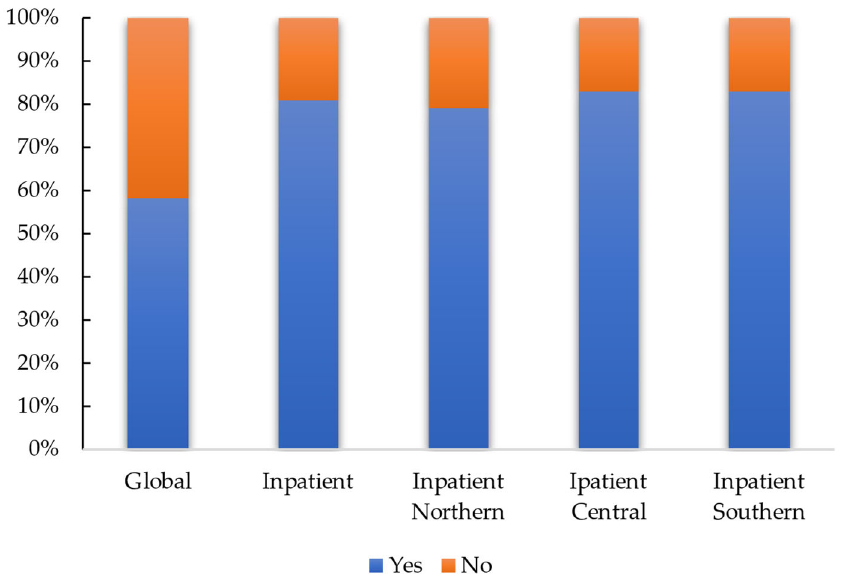
Figure 2. The graph shows the percentage of responses regarding the presence of the multidisciplinary team at national level (global) and focusing the analysis on physiotherapists who work in a hospital setting (inpatient), among these stratifying the data geographically. Distribution: as regards the composition of the multidisciplinary team (item 10), it emerged that the most represented figure is the physiotherapist, and the least represented is the geriatrician. The distribution of composition is shown in Figure 3 (more than one possible answer was